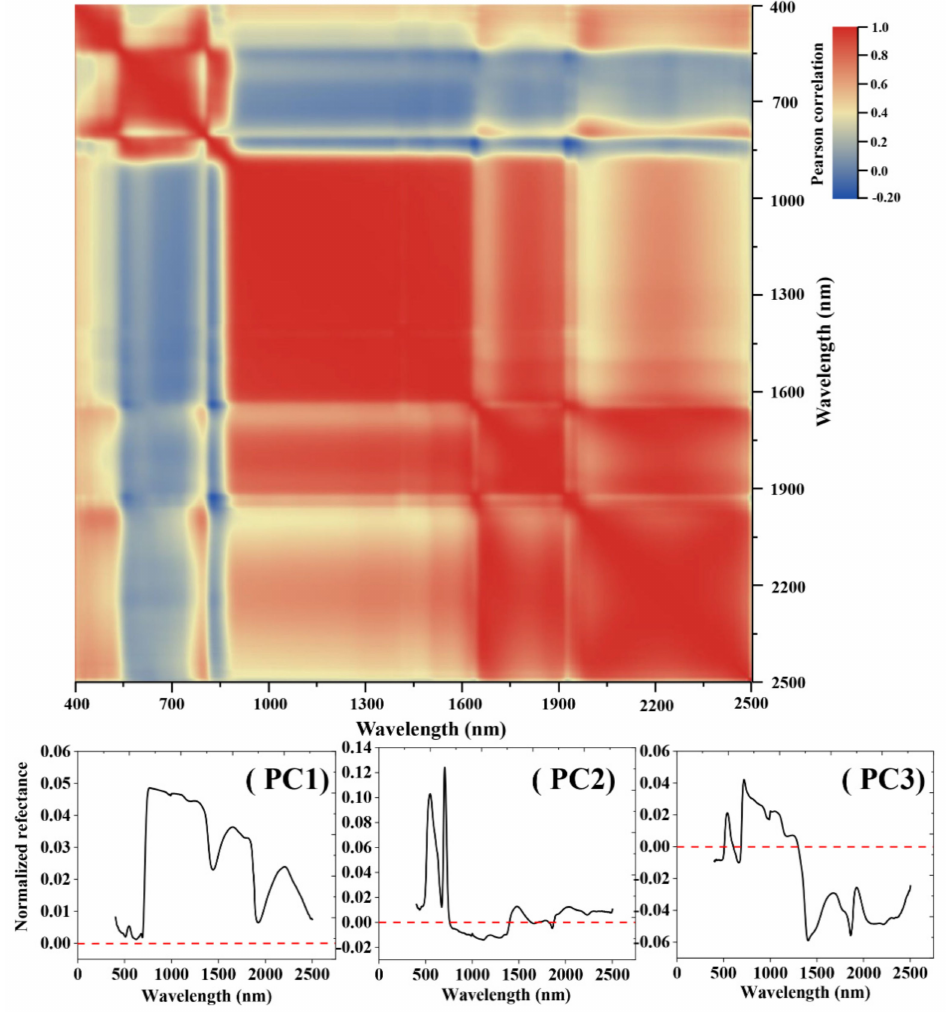
Figure 4. Heat maps of the reflectance spectra of lemon leaves over four drought treatments. Each point shows the Pearson correlation of reflectance at both wavelengths. The panel below shows the three components that account for the largest proportion of